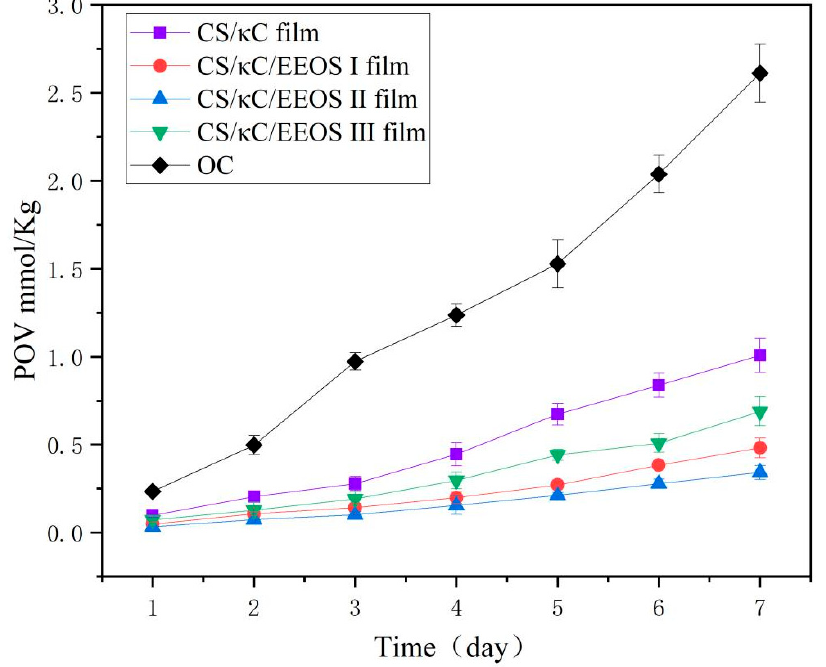
Figure 9. POV values of lard coated with CS/ κ C/EEOS composite films with different EEOS additive levels.